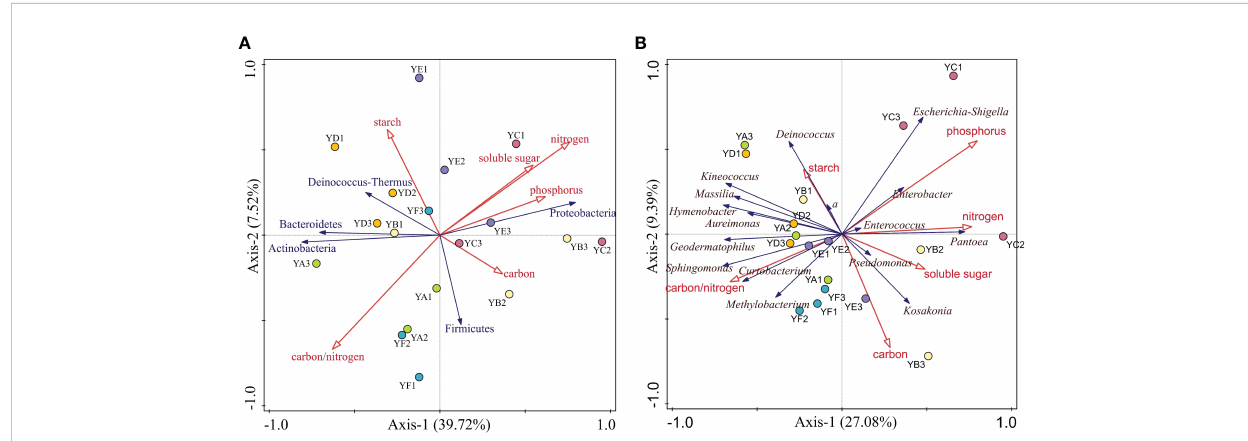
FIGURE 7 Redundancy analysis (RDA) of leaf nutrient factors and relative abundance > 1% of phyllosphere bacterial communities at the phylum (A) and genus (B) level. YA: Populus x euramaricana 'Bofeng 3 hao'; YB: P. deltoides 'Shanghaiguan' x P. deltides 'Harvard'; YC: P. nigra 'N46'; YD: P. nigra 'N102'; YE: P. x euramericana 'Guariento'; YF: P. alba × P. glandulosa